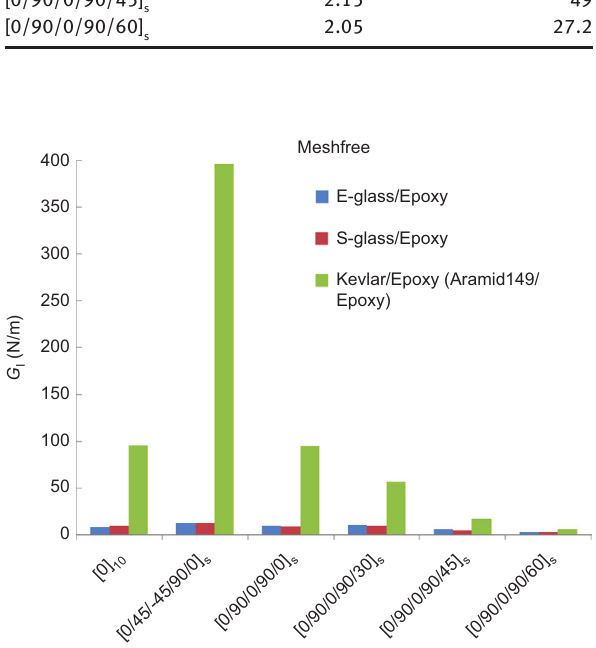
Figure 14 Energy release rates for various orientation angles.